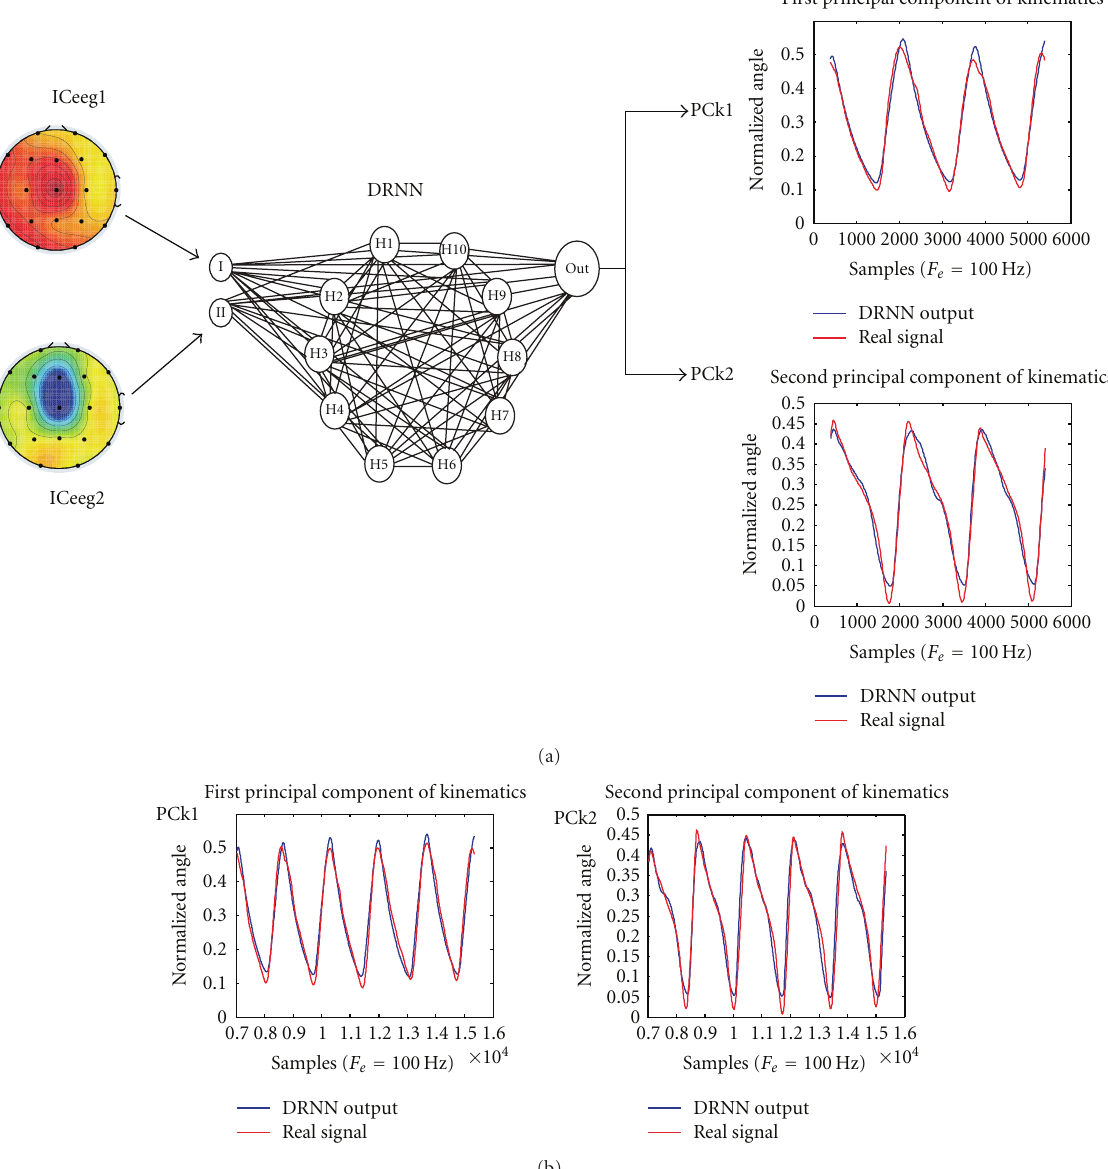
Figure 6: DRNN learning (a) and simulation (b) phases where two independent components (ICeeg 1 − 2 ) were used as input to the DRNN while the two principal components (PCk 1 − 2 ) of the 3 elevation angles foot, shank, and thigh of one lower limb kinematics were used as desired output (modified from